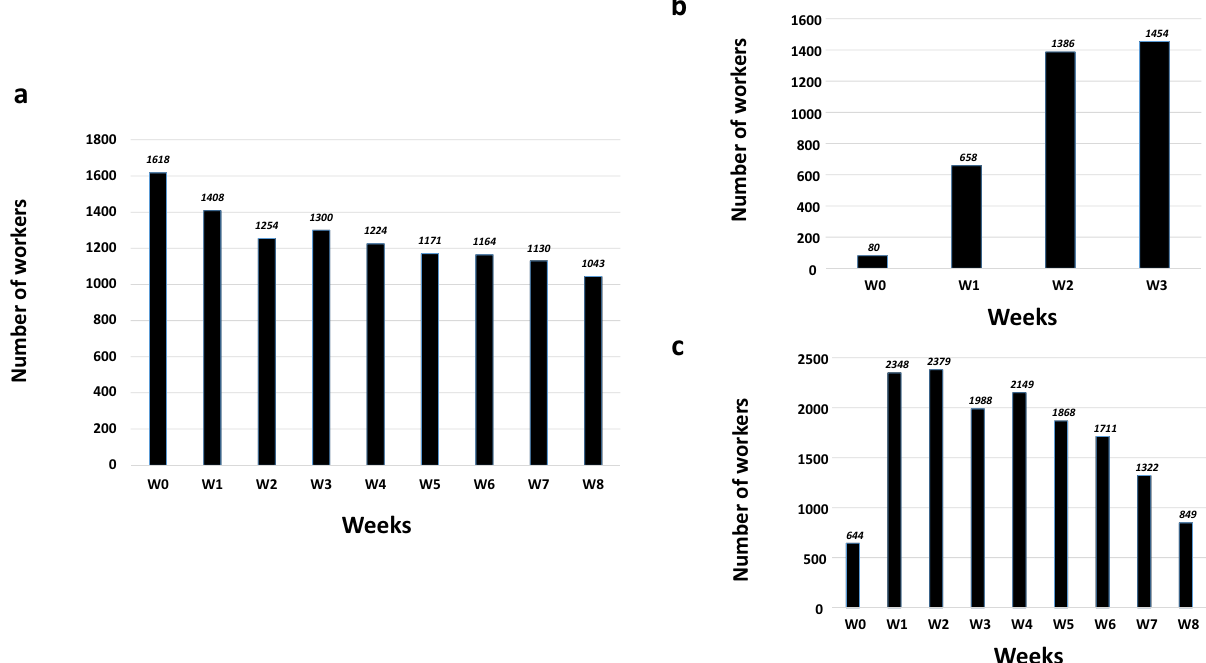
Fig. 3 Sampling effort by week for each group of nursing home workers. a Non-vaccinated group of workers (from 99 nursing homes). b On dose- vaccinated group of workers (from 80 nursing homes). c Two dose-vaccinated group of workers (form 94 nursing homes). The maximum numbers of workers for each group (1618 + 1454 + 2379 = 5451) were close to the 100% of eligible workers (5228). The slight difference is related to the fact that some workers are not